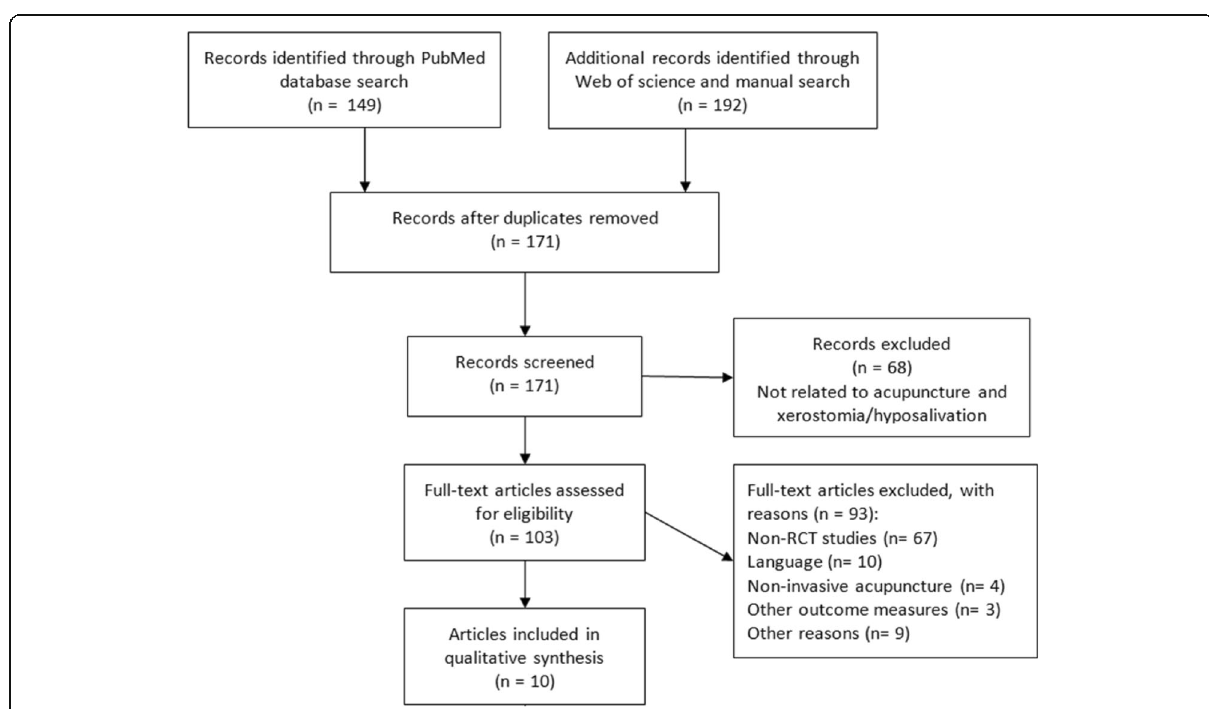
Fig. 1 Prisma flow diagram of the systematic review